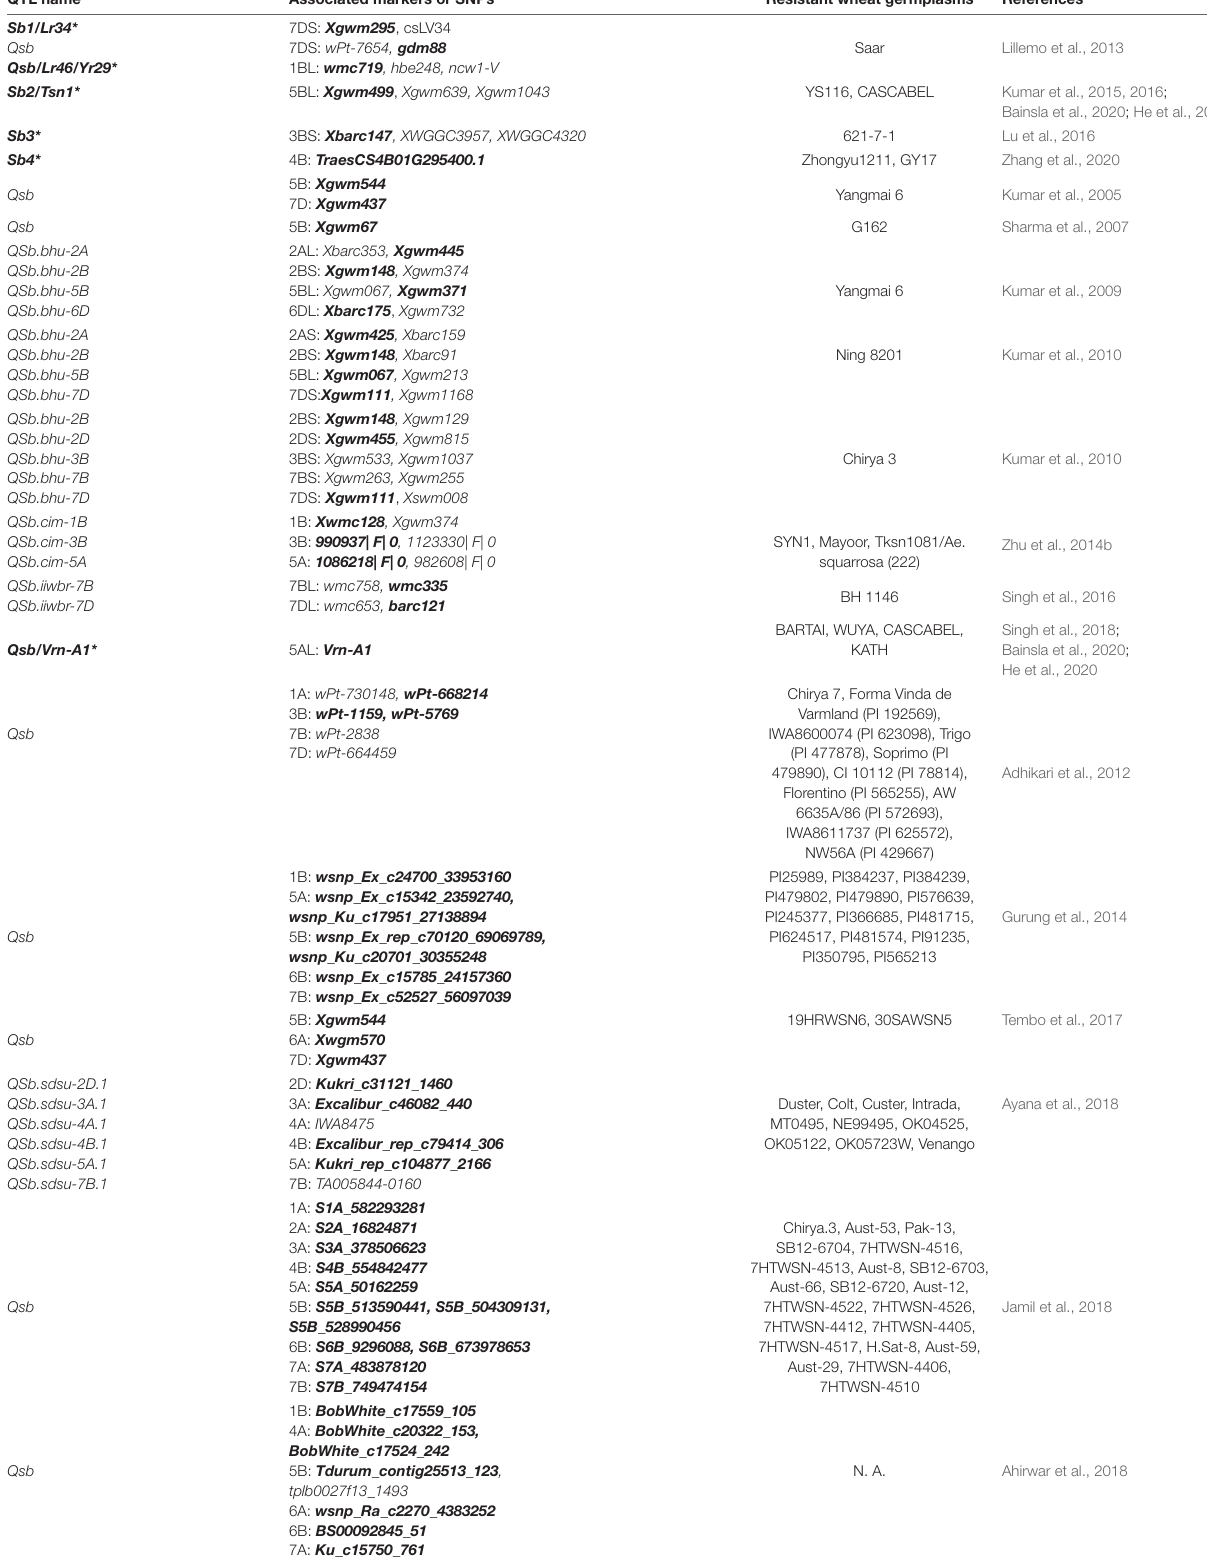
TABLE 1 | Genetics of resistance to common root rot (spot blotch) in